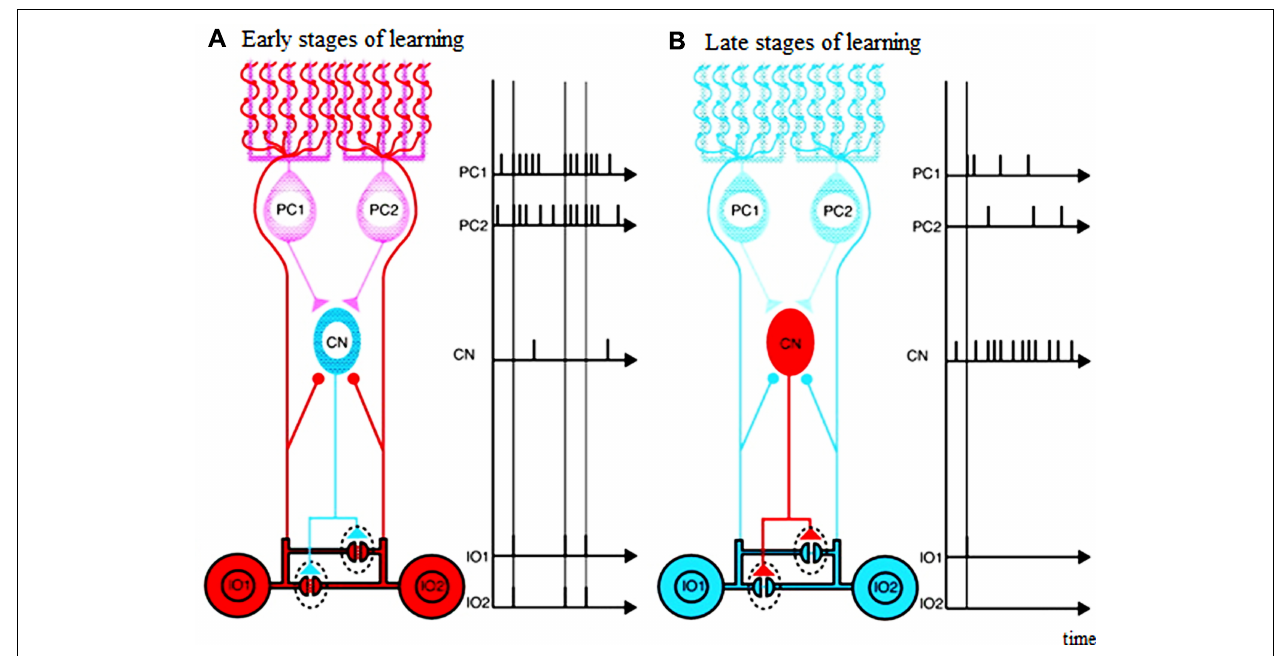
inhibitory interneurons, excitatory deep cerebellar nucleus. Excitatory inputs to inferior olive cells are not shown either. Blue neurons are not excited, and red are excited. Excitatory synapses are shown by circles, and inhibitory synapses are shown by triangles. Horizontal lines show electrical gap junctions. Adapted from Figure 3 in Kawato etal. (2011), itself adapted from Figure 3 in De Zeeuw etal.